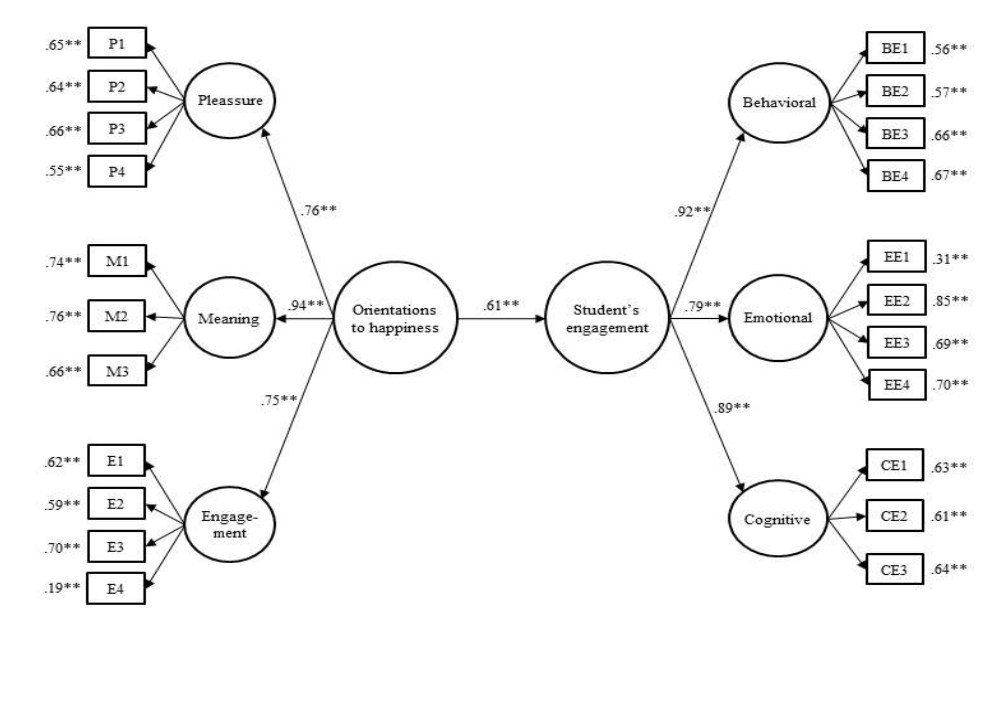
Results of the SEM, Students engagement R 2 = .